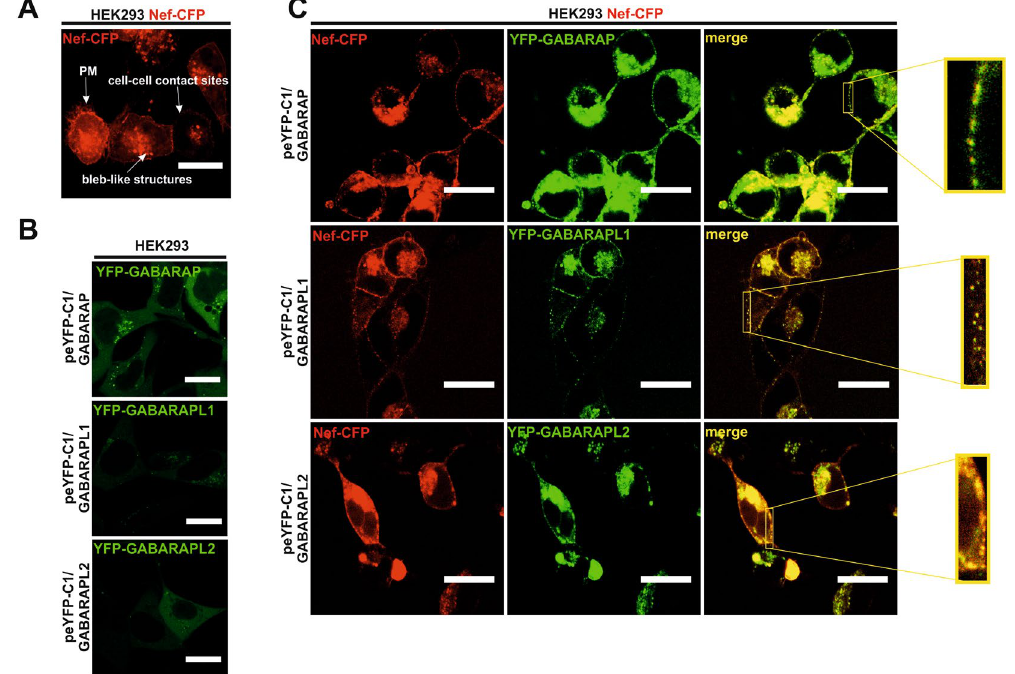
Figure 4. GABARAP, GABARAPL1 and GABARAPL2 colocalize with Nef in vesicular structures. ( A ) Live- cell fluorescence microscopy of HEK293 cells stably expressing Nef-CFP. Here, Nef was observed at cell-cell contact sites, bleb-like structures or at the plasma membrane (PM). Scale bar 20 µ m. ( B ) Live-cell fluorescence microscopy of HEK293 cells transfected with peFP-C1/GABARAP (top), peYFP-C1/GABARAPL1 (middle) and peYFP-C1/GABARAPL2 (bottom) revealed a diffuse distribution pattern for all GABARAPs. Scale bar 20 µ m. ( C ) Live-cell fluorescence microscopy of HEK293 cells stably expressing Nef-CFP (red) and transfected with peFP-C1/GABARAP (top), peYFP-C1/GABARAPL1 (middle) and peYFP-C1/GABARAPL2 (bottom) (all green). In this case, Nef and GABARAPs showed high colocalization levels at vesicular structures and at the plasma membrane (see merge and zoom). Scale bar 20 µ